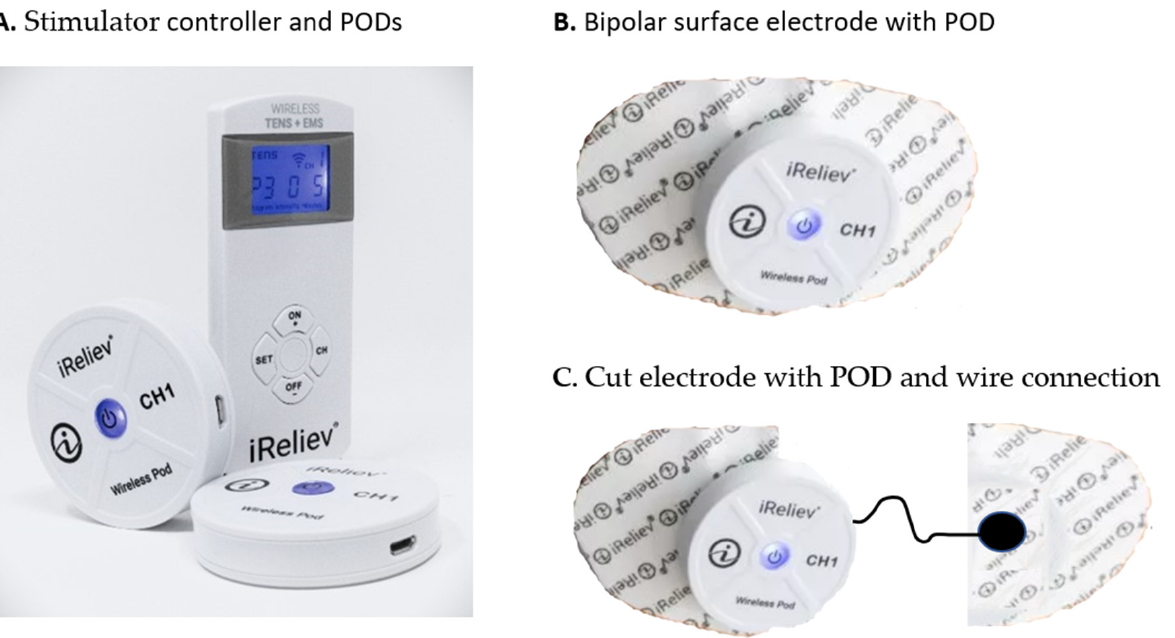
Figure 1. Wireless stimulator (iReliev R ) controller, POD, and surface electrode. ( A ) Controller with two wireless PODs. ( B ) A bipolar surface electrode with POD, which is proposed for unilateral wireless-TIB. ( C ) Two monopolar electrodes from the original electrode that has been cut. This arrangement is proposed for wireless-GEN and bilateral wireless-TIB. The wire and snap connector is shown, see text.